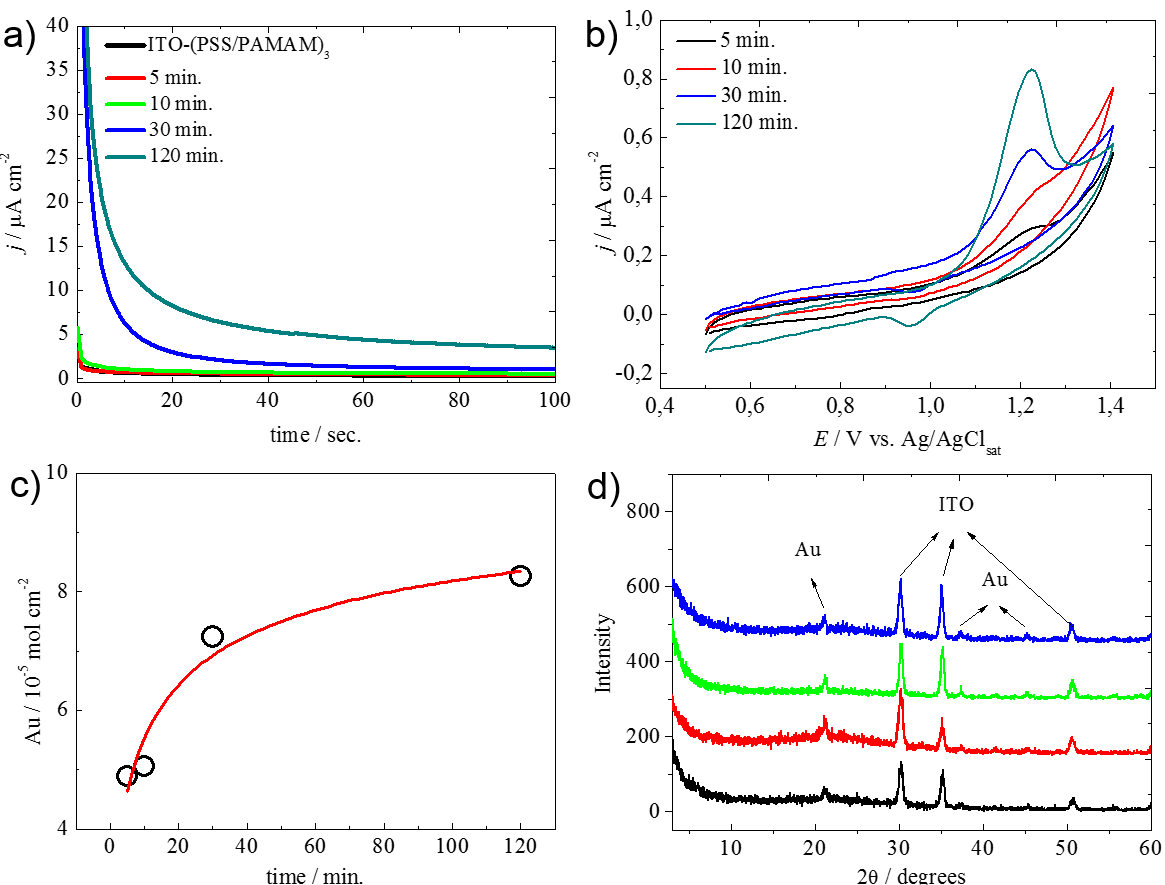
electrodes. For all plots, the color represents: ITO-PAmAm- Figure 2 - AuNPs deposition on ITO-PAmAm-(PSS/PAmAm) 2 (PSS/PAmAm) (black) and ITO-PAmAm-(PSS/PAmAm) electrodes exposed to different times of AuCl 4- adsorption (5 (red), 2 2 10 (green), 30 (blue) and 120 minutes (dark cyan)). Supporting electrolyte: h SO 0.1 mol l -1 . T 25° C. a) Chronoamperometric 2 4 curves (applied potential: 1.2V (vs. Ag/AgCl ). The black curve is superimposed with the red curve. b) Cyclic voltammetry after sat AuNPs deposition. c) Amount of Au deposited onto ITO-PAmAm-(PSS/PAmAm) using different times of AuCl 4- adsorption (5, 2 10, 30 and 120 minutes). d) DRX pattern obtained for the ITO-PAmAm-(PSS/PAmAm) -AuNPs electrodes exposed to different 2 times of AuCl 4- adsorption (5 (red), 10 (green), 30 (blue) and 120 minutes (dark